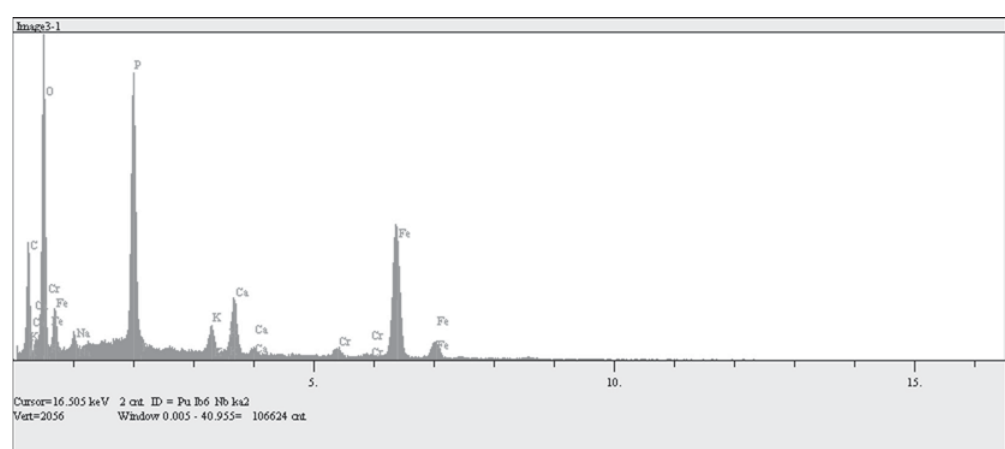
Figure 3- Quantitative energy dispersive x-ray spectroscopy (EDS) reading representative of areas of color change suggestive of corrosion in the soldered region in contact with the band and the wire in a Group II specimen (Periogard® mouthrinse)